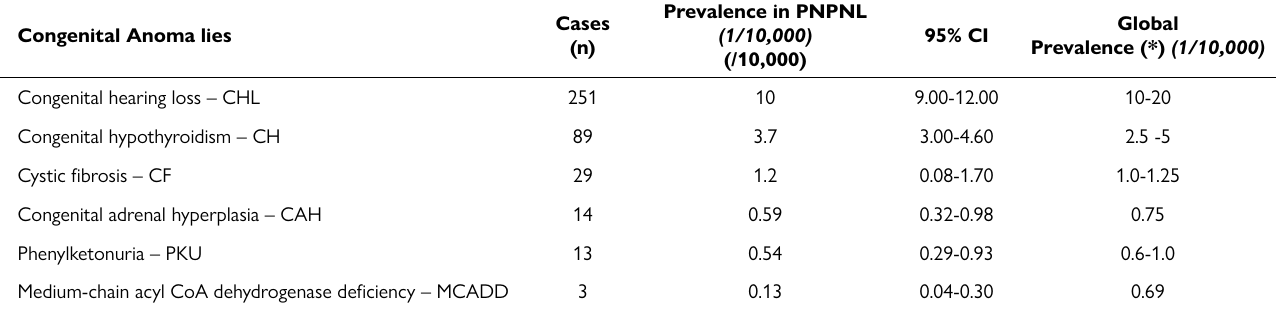
Table 1. Prevalence of diseases detected by the Newborn and Infant Screening Programme and reported to National Registry for Birth Defect and Rare Diseases in Uruguay, from 2010 to